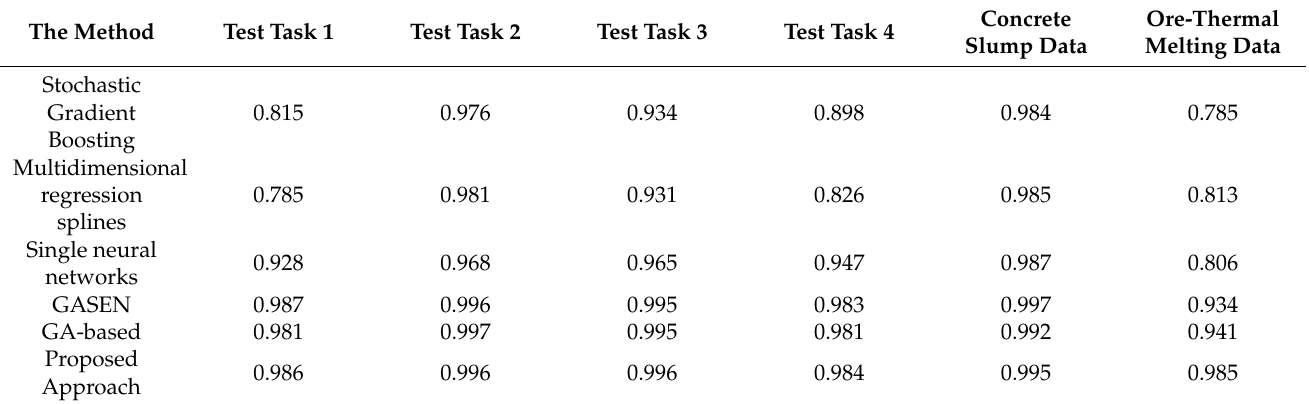
Table 2. Data on the results of the method study on test problems with additive noise 0%.